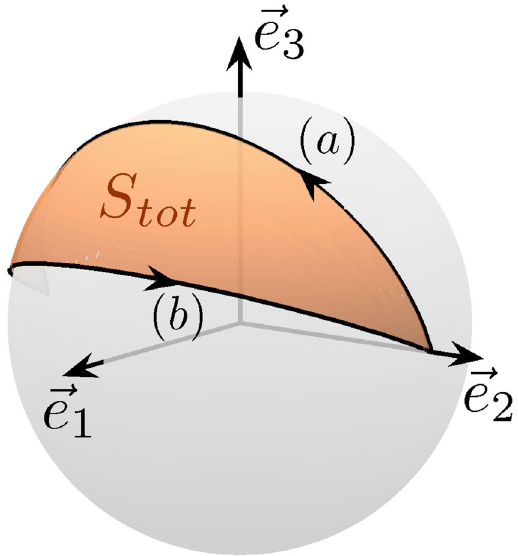
Figure 6. Quantum gate based on the Montgomery phase. Cyclic process on the Bloch sphere for implementing a π /2 phase gate. The loop is the concatenation of the trajectories ( a , b ) which are defined by different values of k (see the main text). The brown (gray) surface is the total geometric phase at the end of the process i.e. S tot = π